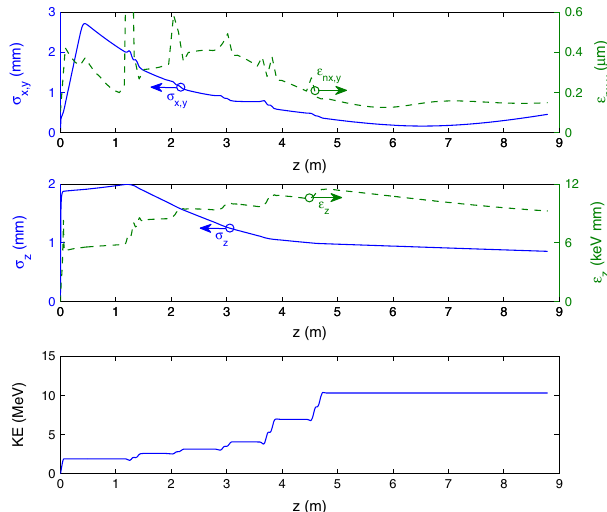
FIG. 11. Beam envelopes for 80 pC ( MTE ¼ 120 meV ) in the SRF gun photoinjector. Larmor rotation removed, ridding the curve of spurious emittance spikes. The most salient difference between the two gun types is in (cid:7) 2 larger beam size at the exit of the dc gun as opposed to the SRF gun, as well as a more dramatic bunch length variation along the longitudinal position in the dc gun photoinjector. The final beam parameters, how- ever, end up being quite comparable between the two gun types. Finally, Fig. 12 shows the final transverse and lon- gitudinal phase spaces near the beam waist ( z ¼ 9 : 5 m for the dc and z ¼ 7 m for the SRF guns).